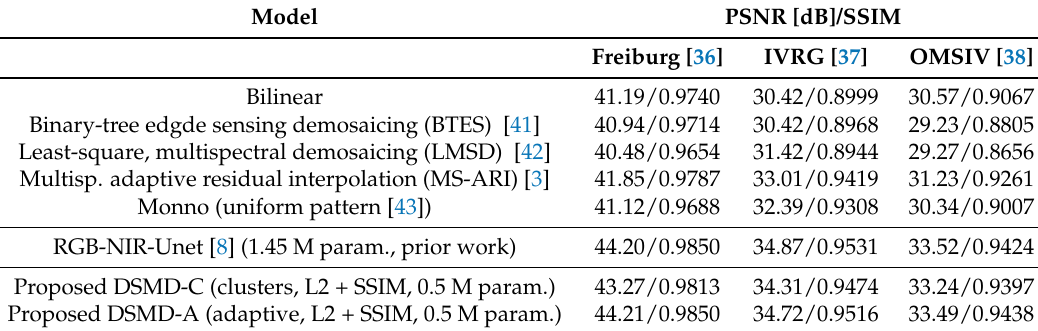
Table 3. Comparison of the performance of the proposed method with existing classical demosaicing methods from the